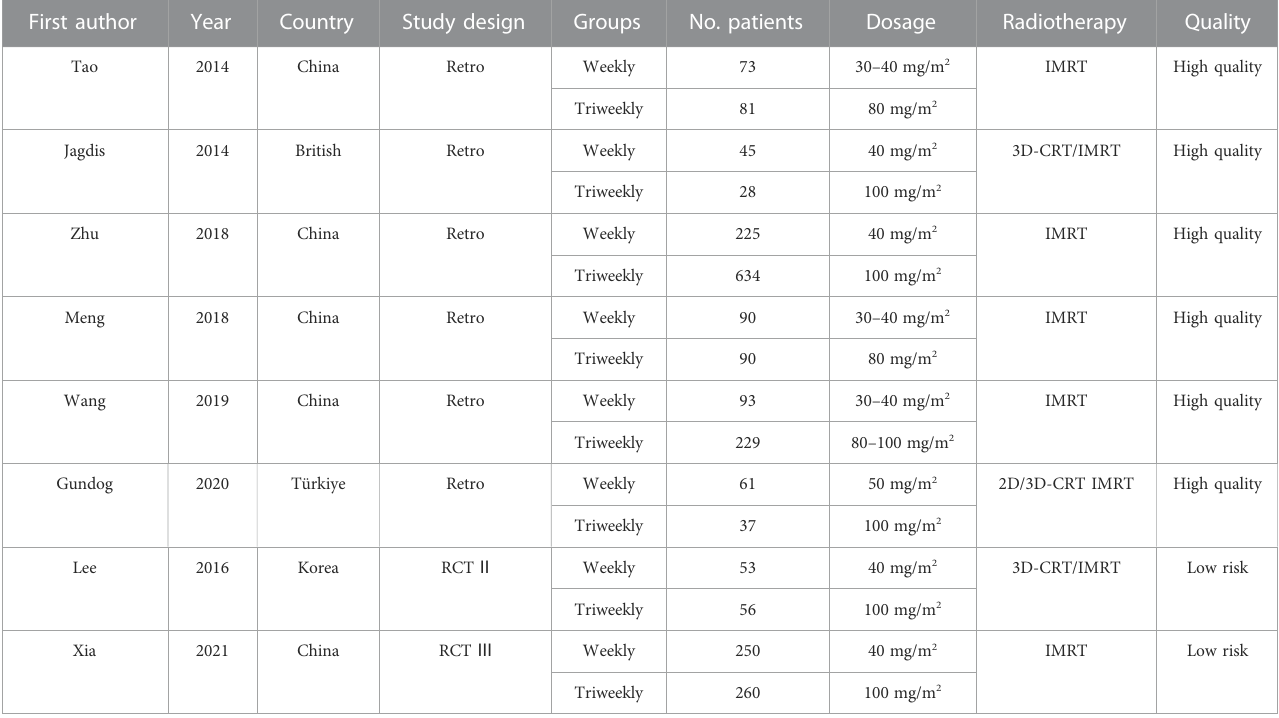
TABLE 1 Main characteristics of the included